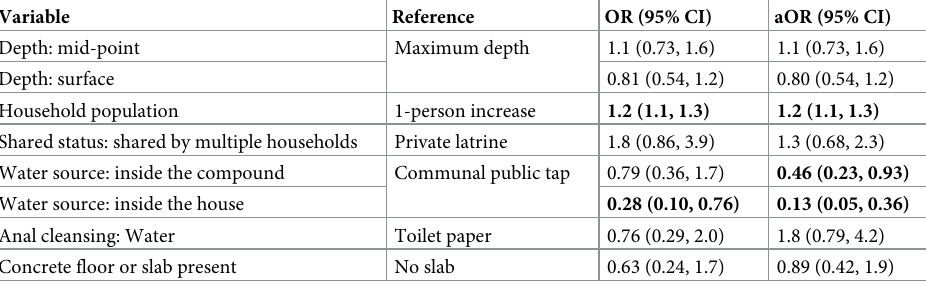
gen detection (aOR = 1.2, 95% CI = 1.1, 1.3); latrines shared among multiple households were not associated with pathogen detection compared to private latrines (aOR = 1.3, 95% CI: 0.68, 2.3); both having a water source inside the compound (aOR = 0.46, 95% CI: 0.23, 0.93) and inside the home (aOR = 0.13, 95% CI = 0.05, 0.36) were associated with reduced odds of patho-